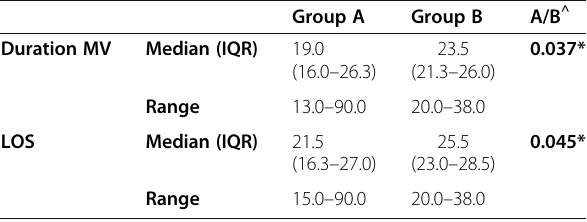
Table 6 Comparison between case and control groups